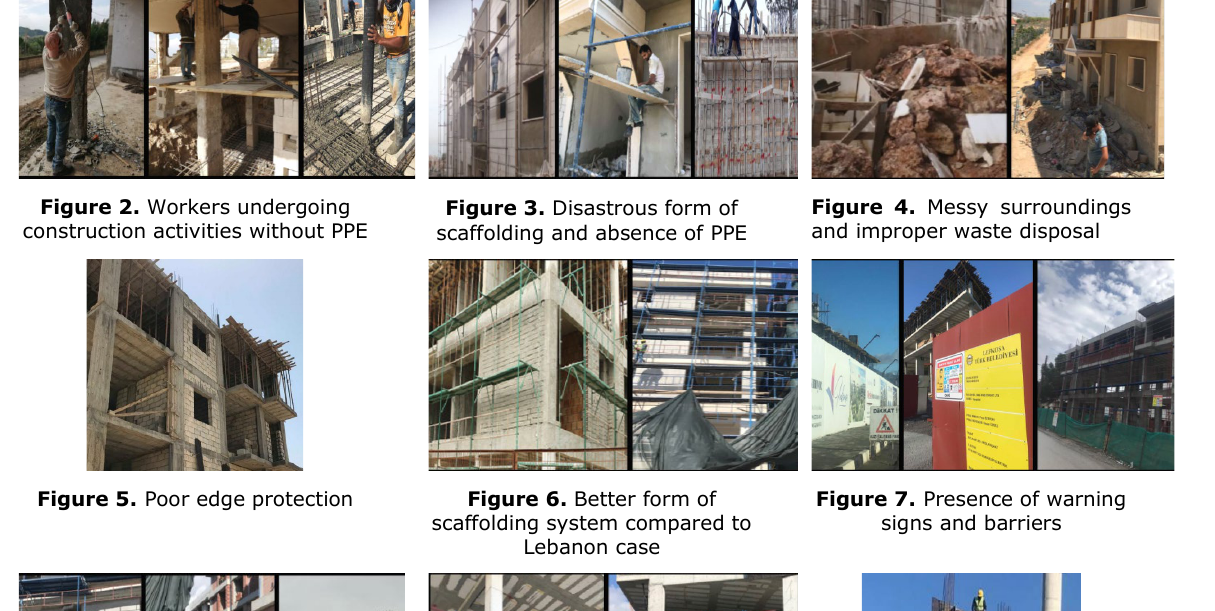
Figure 7. Presence of warning scaffolding system compared to signs and barriers Lebanon case